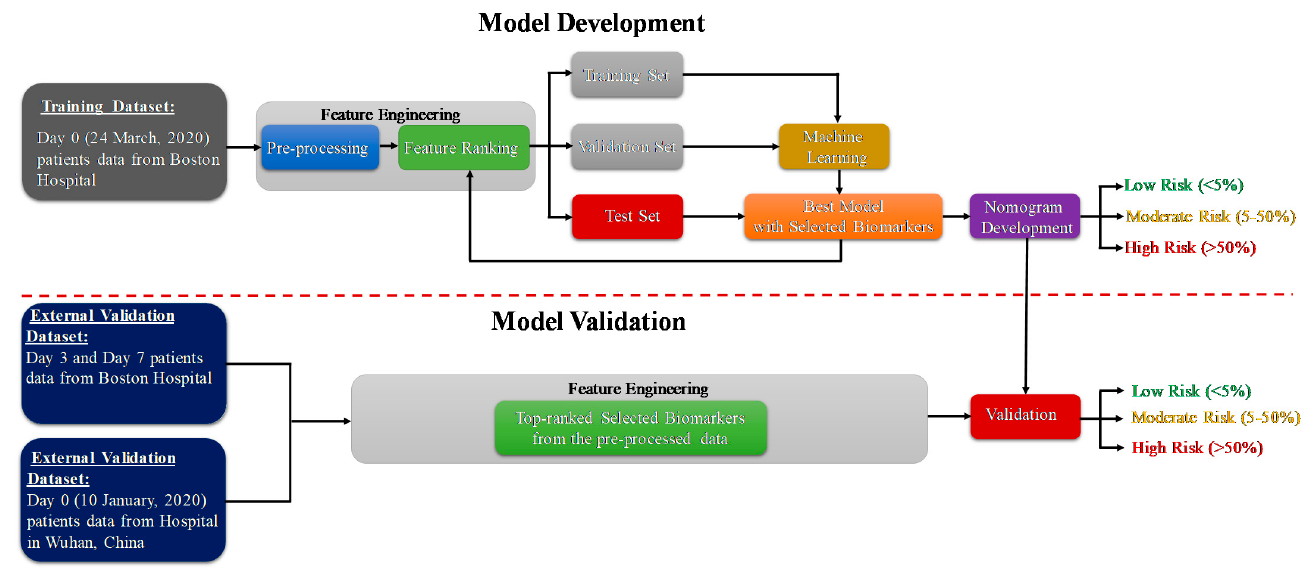
Figure 1. Methodology of the study.